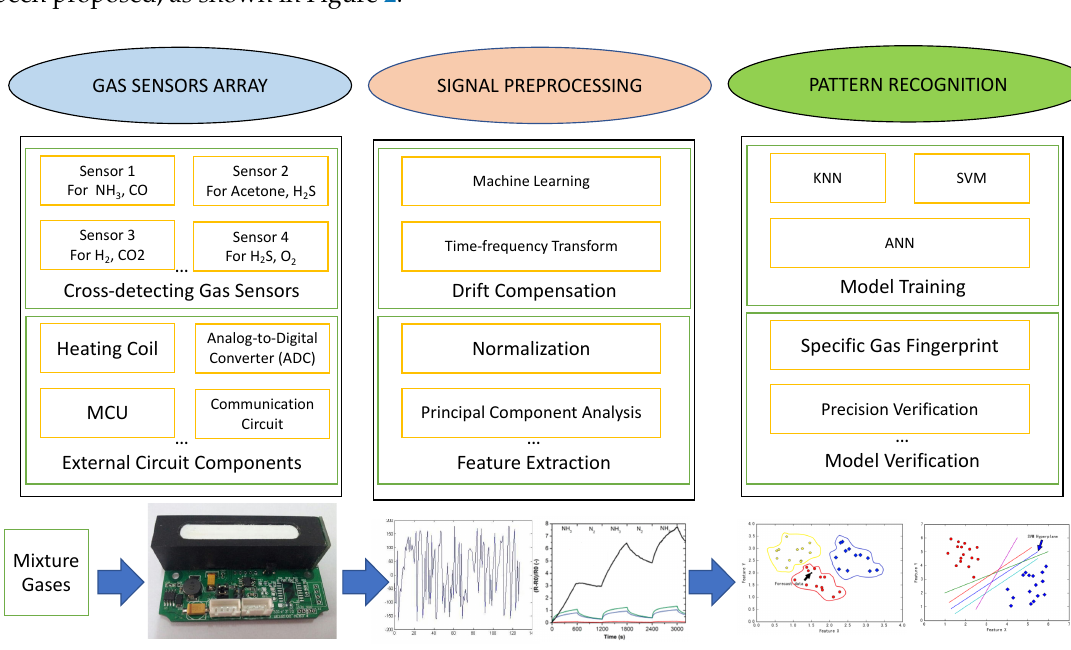
Figure 2. The step of Smart Gas